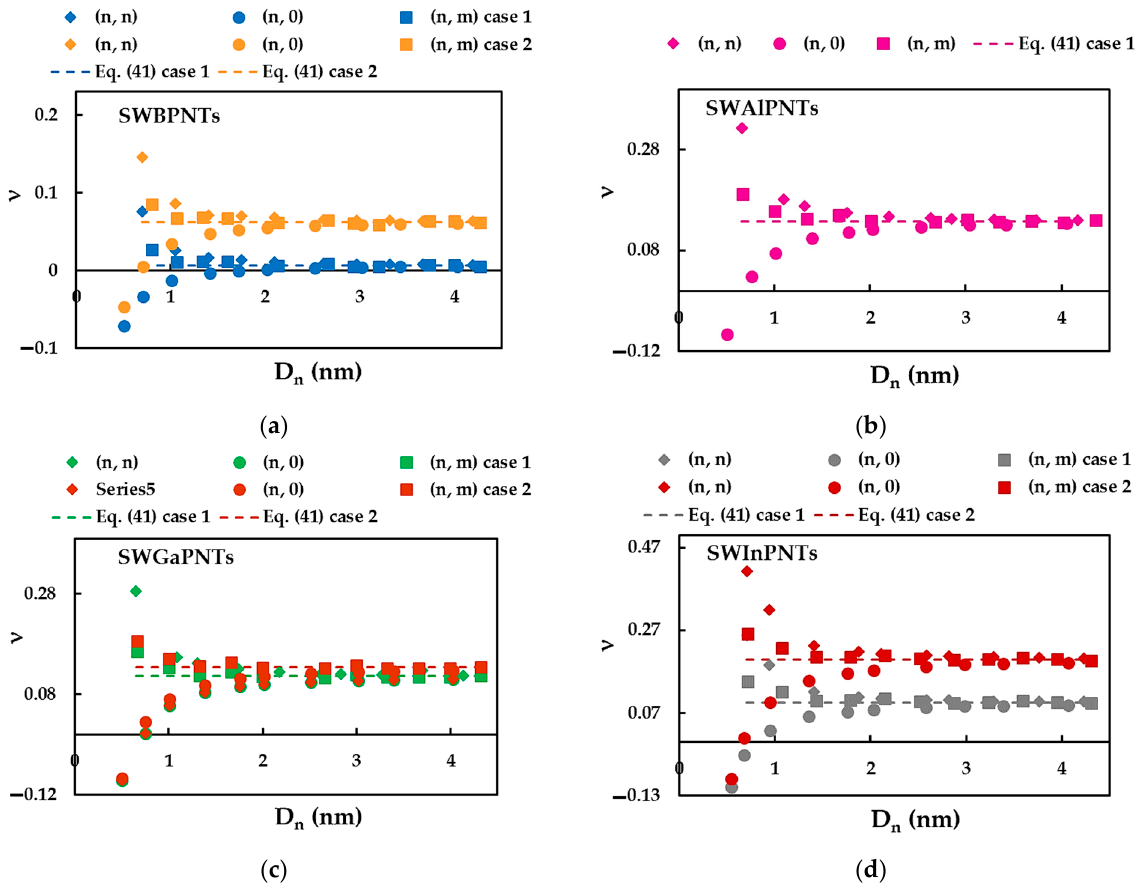
Figure 17. Evolution of the Poisson´s ratio, ν , as a function of the nanotube diameter, D n , for: ( a ) SWBPNTs, ( b ) SWAlPNTs, ( c ) SWGaPNTs and ( d ) SWInPNTs.